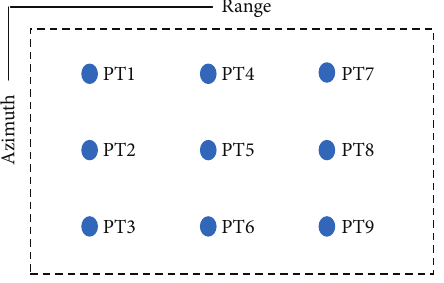
Figure 4: Simulation scene that contained nine point